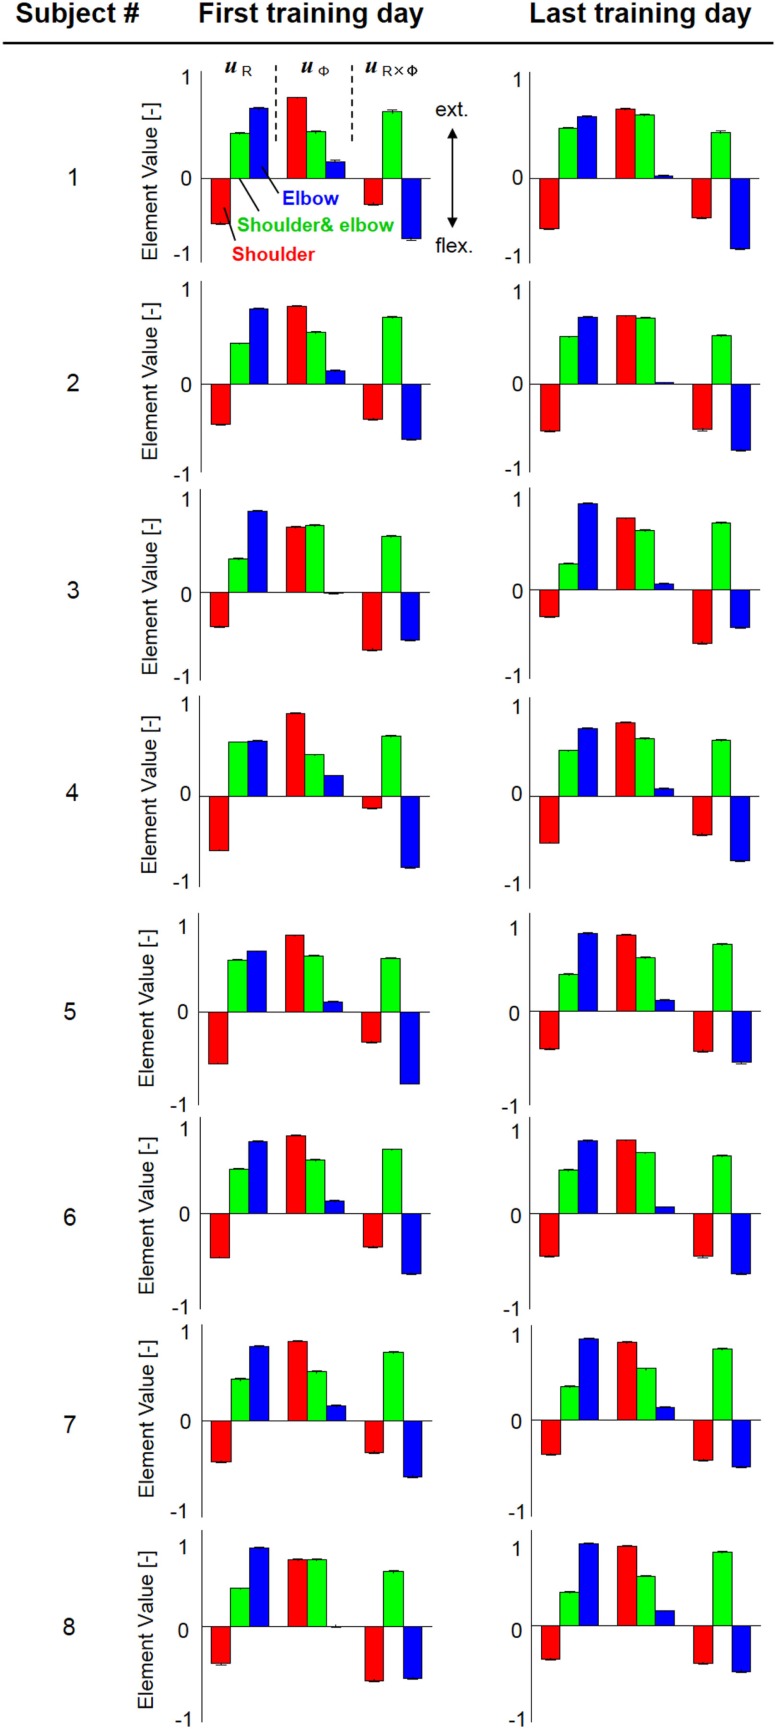
Muscle synergies from the first and last days of voluntary training for eight subjects. The three-bar sets represent the muscle synergies in the radial direction (uR), tangential direction (uφ), and null direction (uR×φ). Each colored bar in the muscle synergy indicates the contribution of agonist–antagonist muscle activities to the shoulder (red), shoulder and elbow (green), and elbow joint (blue) movement. Muscle synergies exhibited similar patterns regarding both intra- and inter-individual variations during training, demonstrating the existence of common and invariant reference frames for motor representation that are independent of the level of motor learning.